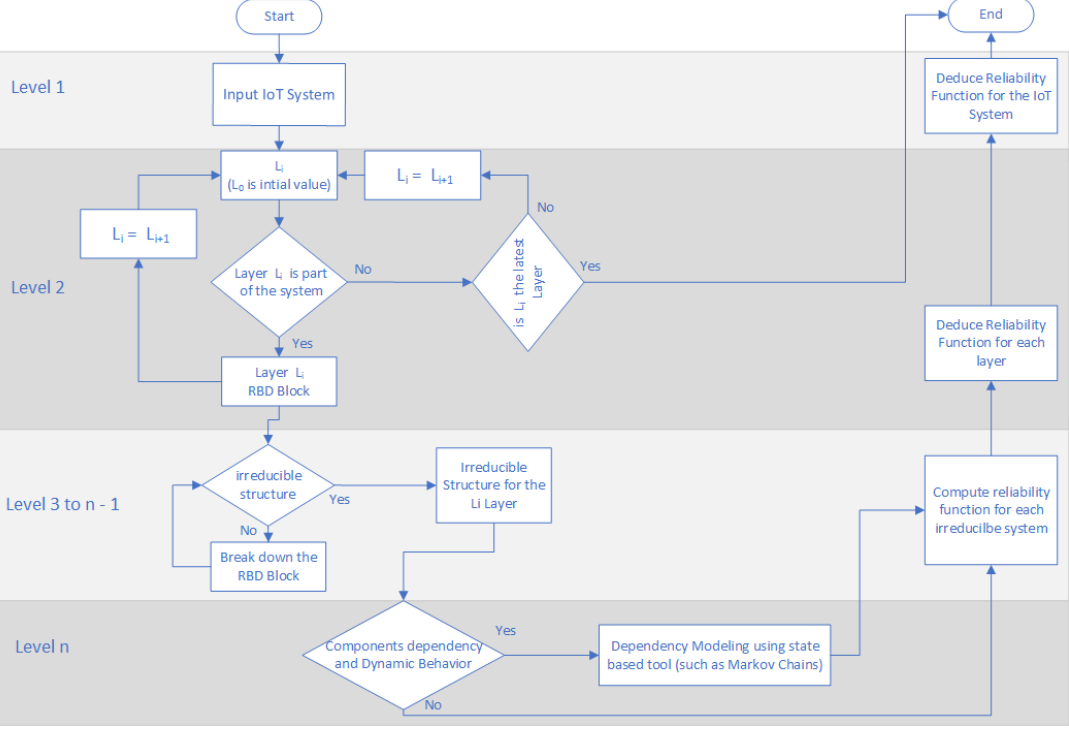
Figure 15. Framework deployment flow